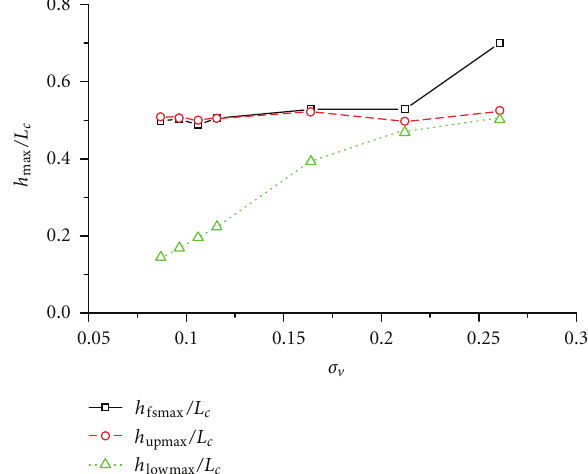
Figure 15: Positions located in the maximal level of the free surface and the maximal width of the cavity surface at di ff erent σ v , h/H = 0 .